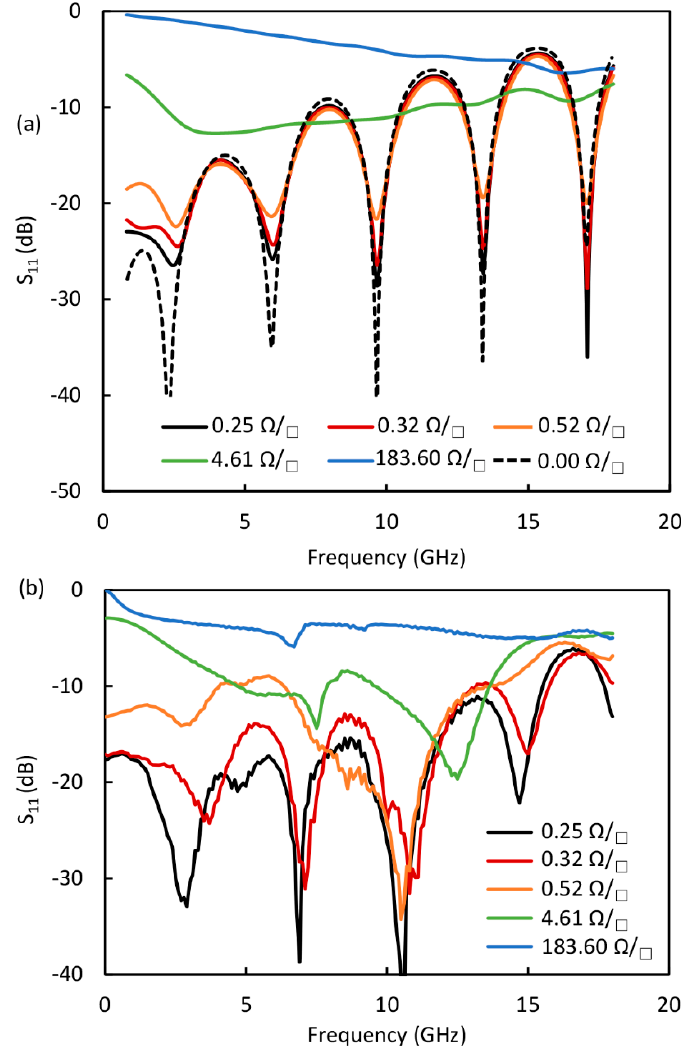
Figure 6. S 11 spectra at various sheet resistances: ( a ) simulation results; ( b ) experiment results.